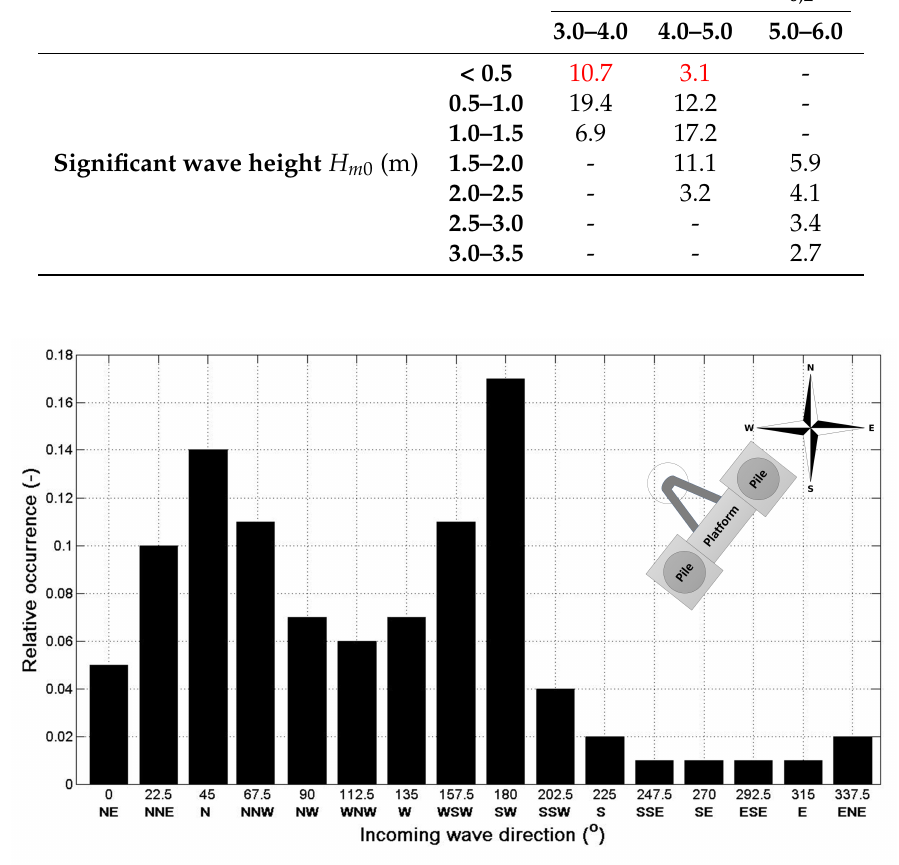
Figure 4. Probabilities of occurrences of different incoming wave